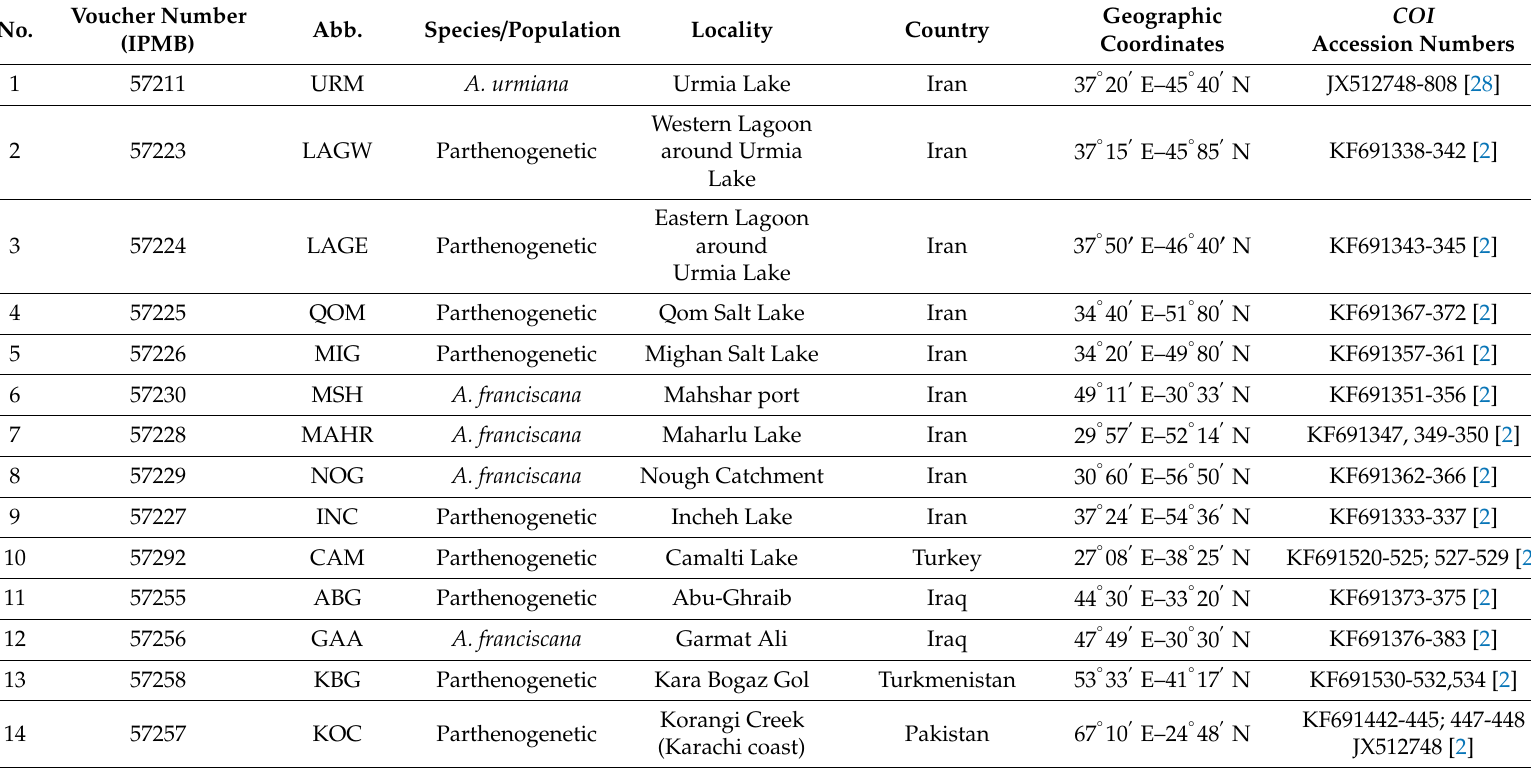
Table 1. Origin of Artemia samples from Iran and neighbor regions. (IPMB = Institute of Pharmacy and Molecular Biotechnology, Heidelberg University, Abb. =